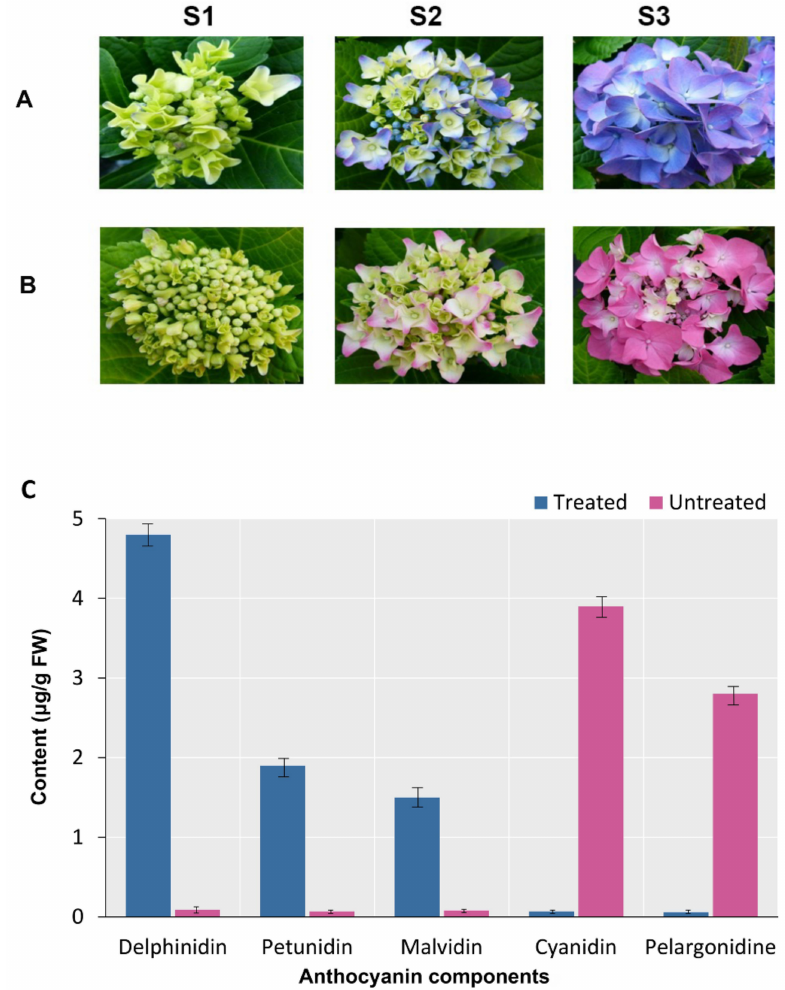
Figure 1. Different development stages of Hydrangea macrophylla . ( A ): The sepal of plants grown in acidic soil changed from pale yellow to blue–violet. ( B ): The sepal of plants grown in untreated soil changed from pale yellow to pink. ( C ): Anthocyanins contents of sepal in S3. Bars are the mean of triplicate determinations and standard